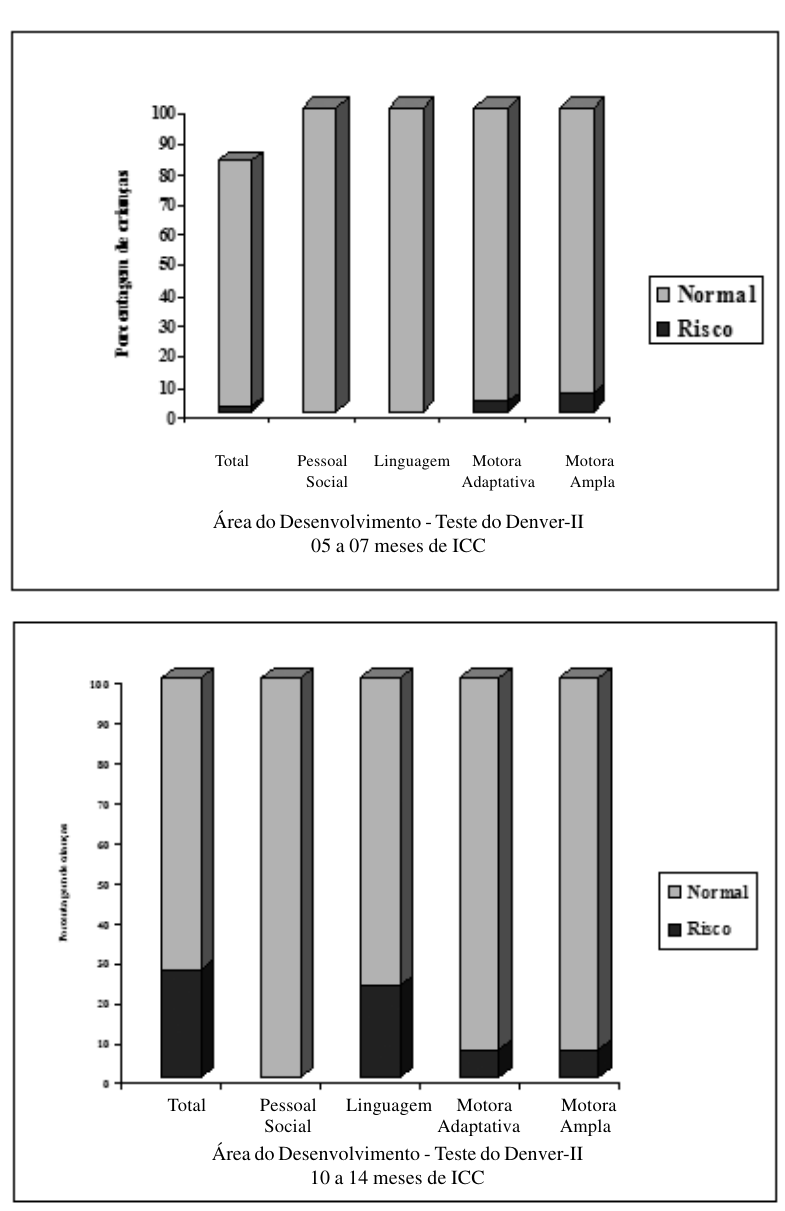
Figura 1. Desempenho no Denver-II das crianças nascidas pré-termo nas faixas de 5 a 7 e 10 a 14 meses de